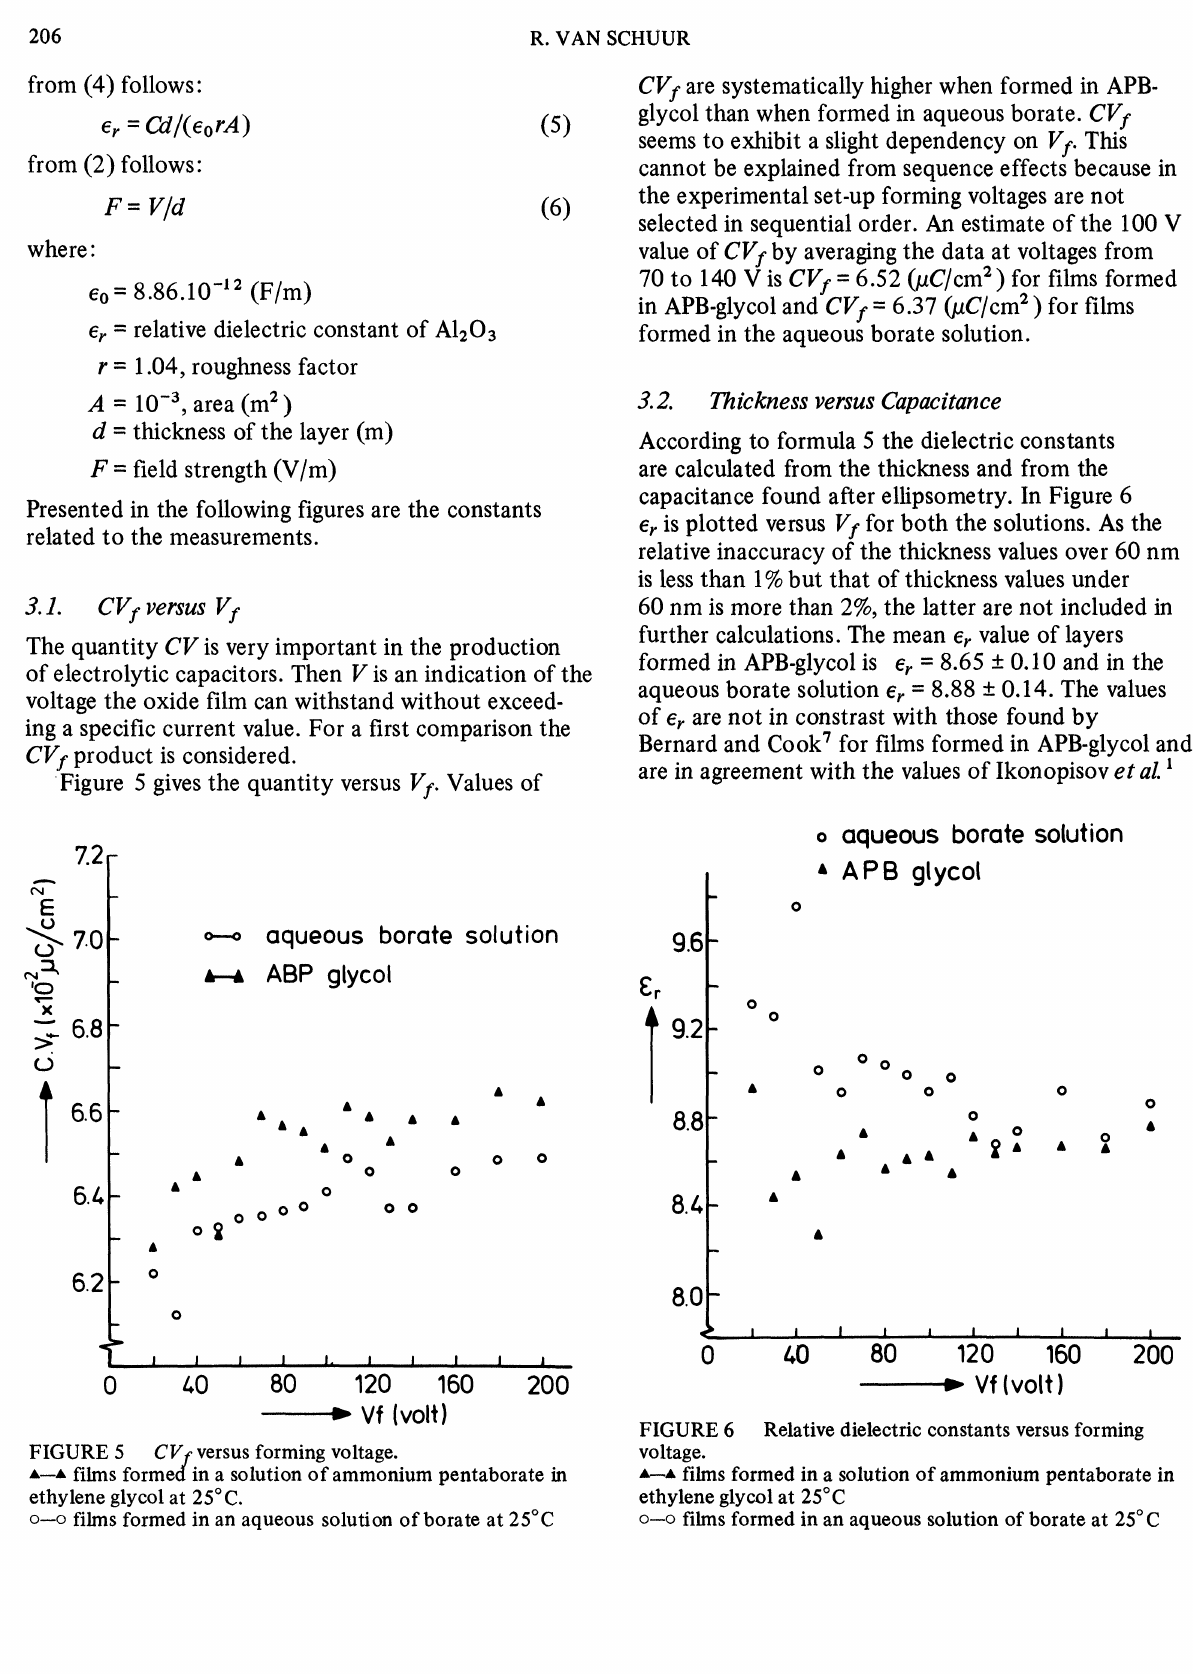
Relative dielectric constants versus forming voltage. --A films formed in a solution of ammonium pentaborate in ethylene glycol at 25C o--o films formed in an aqueous solution of borate at 25